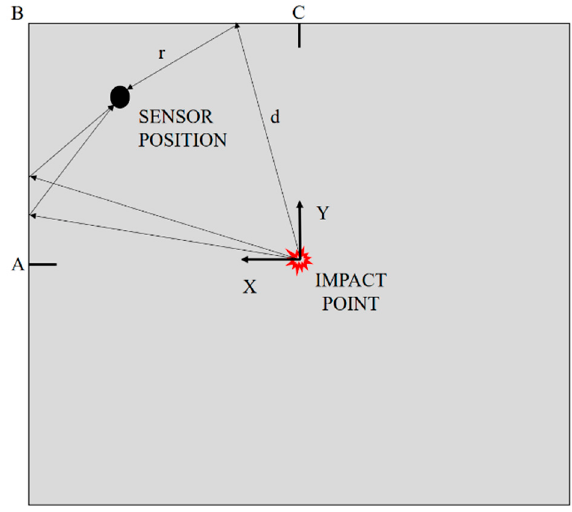
Figure 13. Schematic of the strain wave reflections at boundary edges after impact.